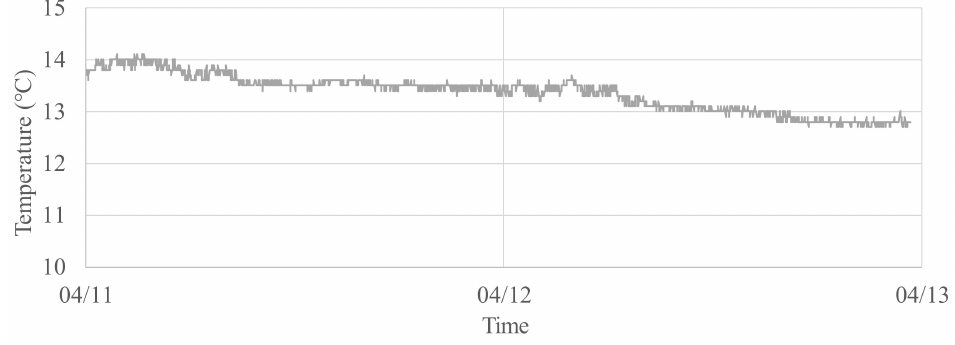
Figure 15. Underground temperature at a depth of − 3 m (Heating period).